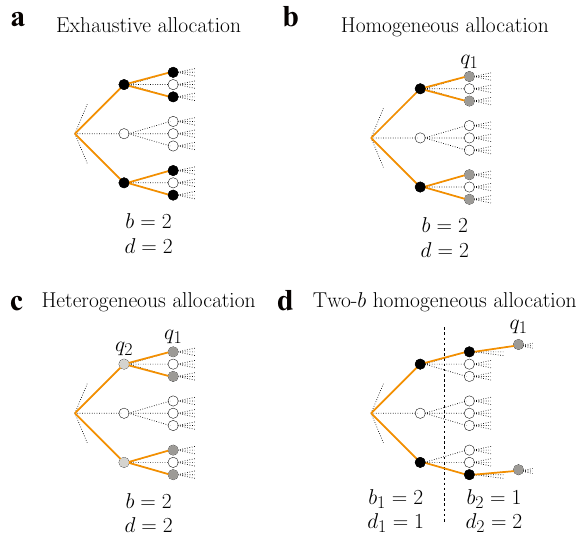
Figure 2. Families of allocation policies to sample an infinite decision tree. ( a ) In exhaustive allocation, the agent fully samples (black dots) the nodes with chosen branching factor b and tree depth d . ( b ) In homogeneous allocation, the agent chooses the branching factor b and samples as deep as resources allow. The first d − 1 levels of the tree will be allocated with probability one (black dots), while the sampling probability of the last level q 1 ≤ 1 (grey dots) is chosen such that the average capacity constraint in Eq. (6) is satisfied. ( c ) In heterogeneous allocation, the agent is free to choose the branching factor b and the probability q d − l + 1 of sampling the nodes (grey dots) at the l − th level (note reversed order of index). Nodes in the same level share the same probabilities of being sampled. Sampling probabilities are chosen such that the average capacity constraint in Eq. (6) is satisfied. ( d ) In two- b homogeneous allocation, the agent samples the first d 1 levels of the tree with branching factor b 1 and the following d 2 levels with b 2 . As in homogeneous allocations, only nodes in the last level of the tree are allocated with non-one probability q 1 (grey dots) such that the average capacity constraint in Eq. (10) is